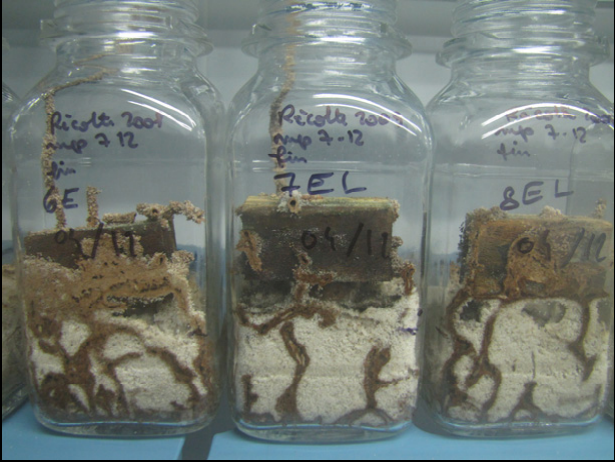
Fig. 7. Culture flasks (test device) with termites.